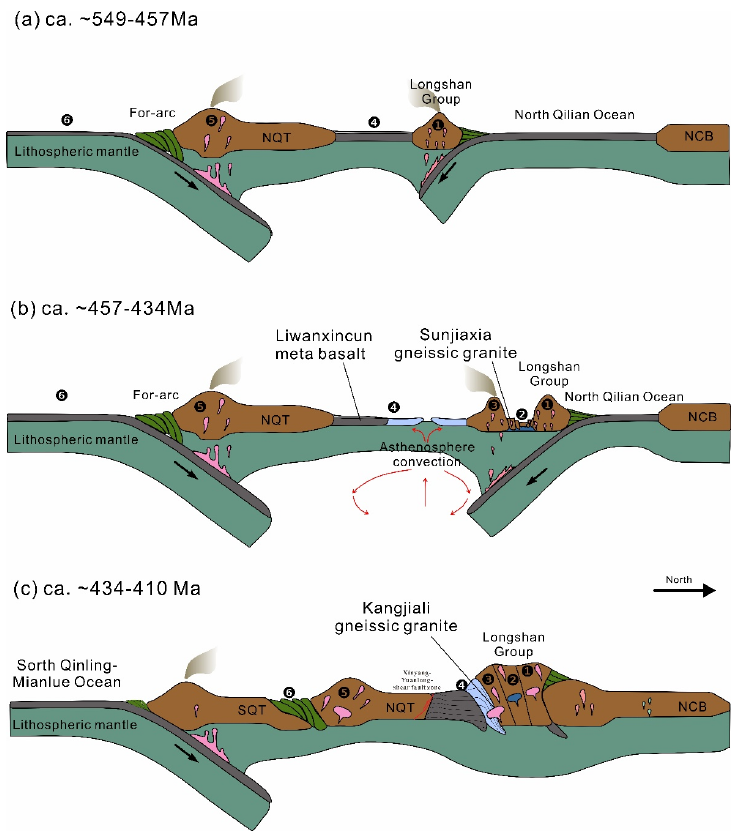
Figure 19. A tectonic model for Early Paleozoic (~549–410 Ma) development of the Sunjiaxia-Tianshui area, involving generation of continental island arc and back-arc basin, closure of oceanic plate and back-arc basin and collision between the NCB and NQT. ( a ) The ca. ~549 – 457 Ma Ma subduction of the North Qilian oceanic plate and the generation of the Yanjiadian-Xinjie continental arc; ( b ) the ca. ~457–434 Ma generation of the Maojiamo-Xiwali inter-arc rift basin and coeval Chenjiahe-Wangjiacha continental island arc, followed with the spreading of Hongtubao back-arc basin ridge; ( c ) the ca. ~434–410 Ma closure of the Huluhe-Hongtubao back-arc basin and collision between the NQT and NCB. During the spreading process of North Qinling Ocean, the NQT turned into an island volcanic arc (ca. 549 Ma [91]) and was then accreted onto the NCB. The oceanic lithosphere of North Qinling-Shangdan Ocean was still subducting towards the north beneath NQT at ca. 508 Ma, revealed by Liushuigou intermediate-basic meta-igneous rocks in Guanzizhen area [94]. The timing of subduction in early Paleozoic can be constrained by Guanzizhen subduction-related gabbro and Miaogou back-arc basin type pyroxenite, which yields TIMS zircon U-Pb ages of 507.5 ± 3.0 Ma [94], and LA-ICPMS zircon ages of 485 ± 5 Ma [99], respectively.